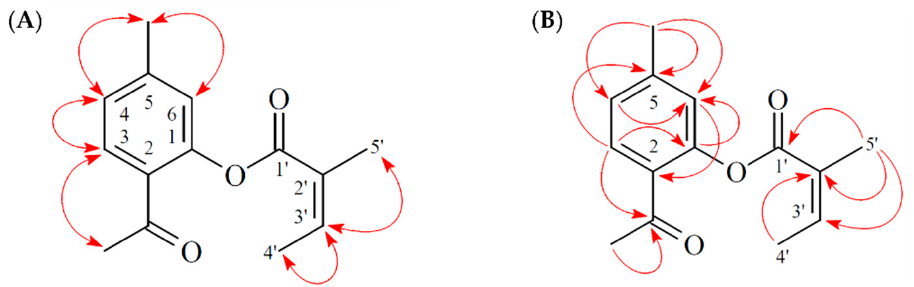
Figure 5. Key ROESY ( A ) and HMBC ( B ) correlations of 4 . Table 3. 1 H and 13 C NMR data of 4 .